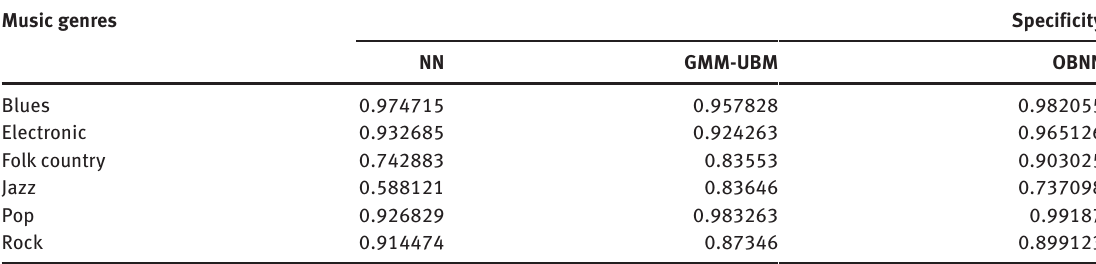
Table 3: Specificity Evaluation Results between NN, GMM-UBM, and OBNN.